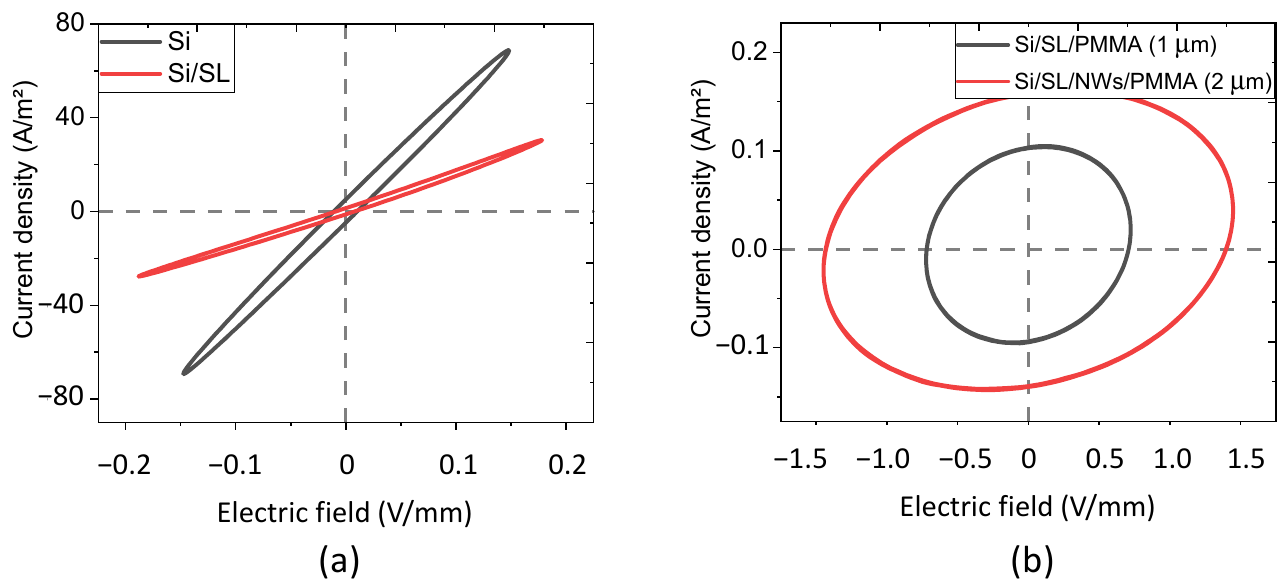
Figure 13. Representative current density versus the electric field of ( a ) resistive-like samples including Si and Si/SL; ( b ) capacitive-like samples including Si/SL/PMMA (1 µm) and Si/SL/NWs/PMMA (2 µm).